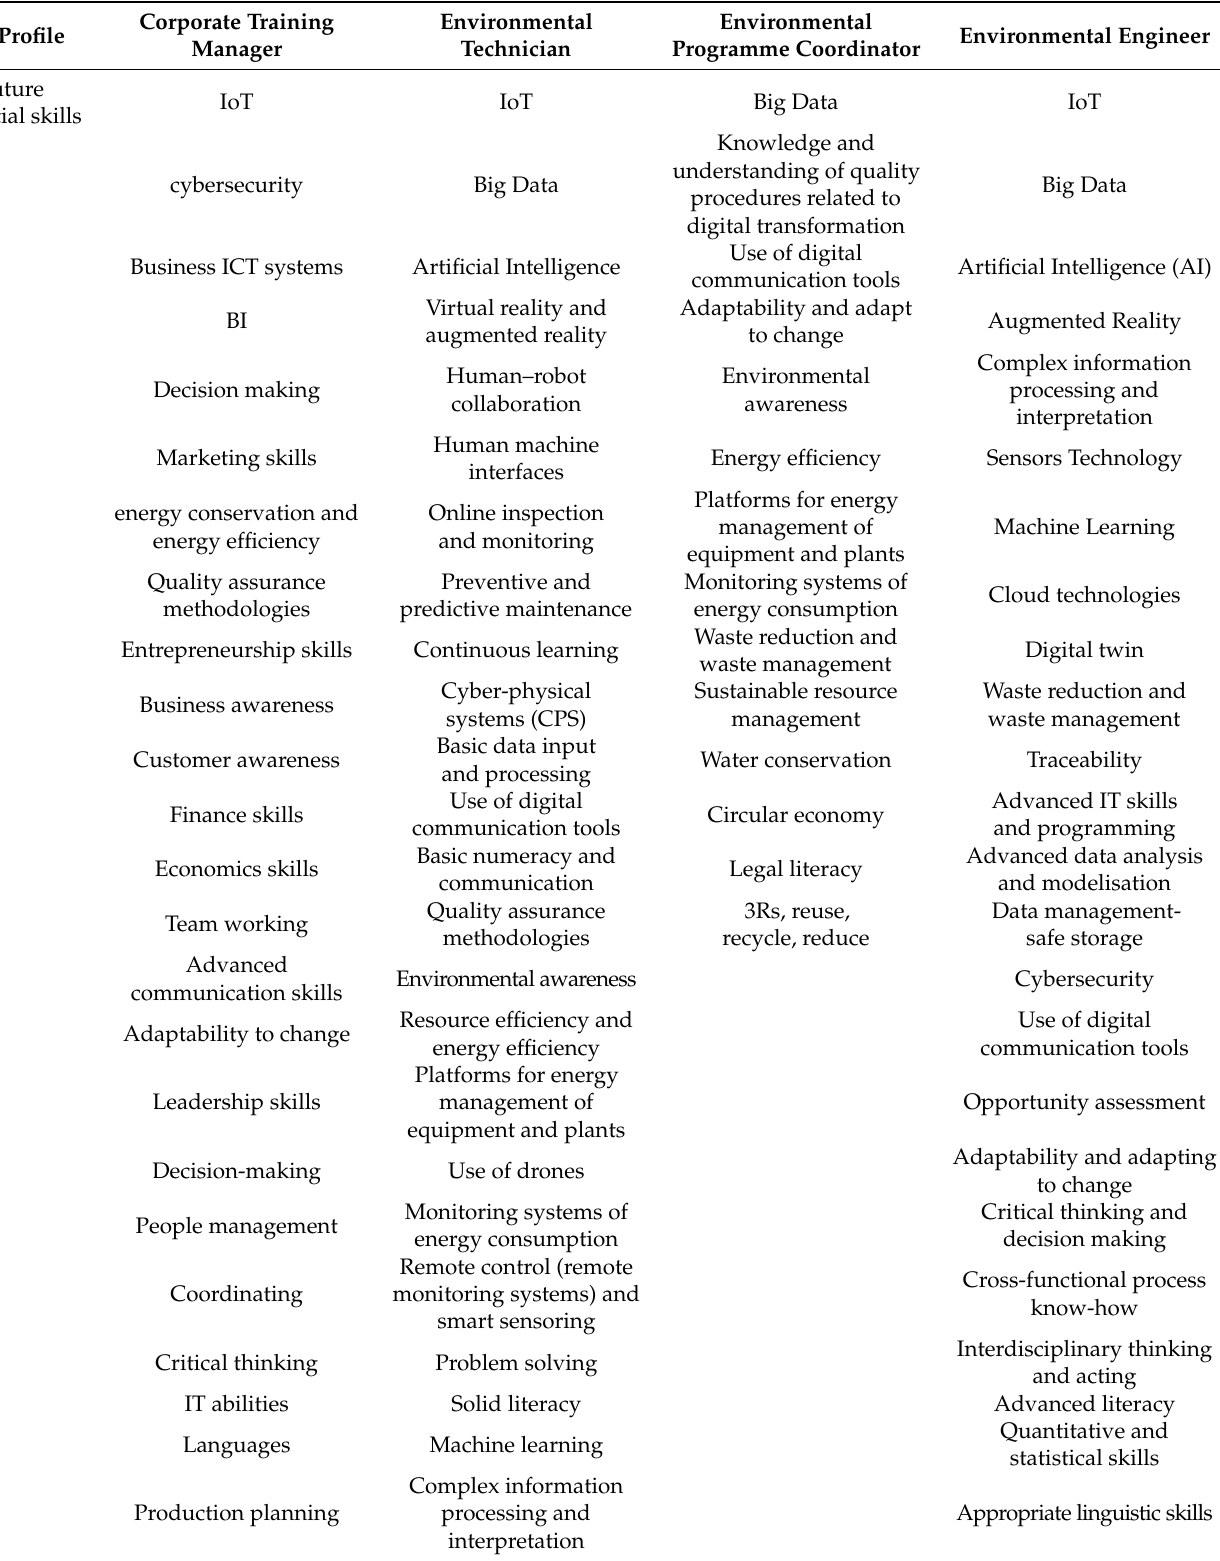
Table 6. An overview of the generated database: identified future skill needs of the selected job profiles, categorised as essential and